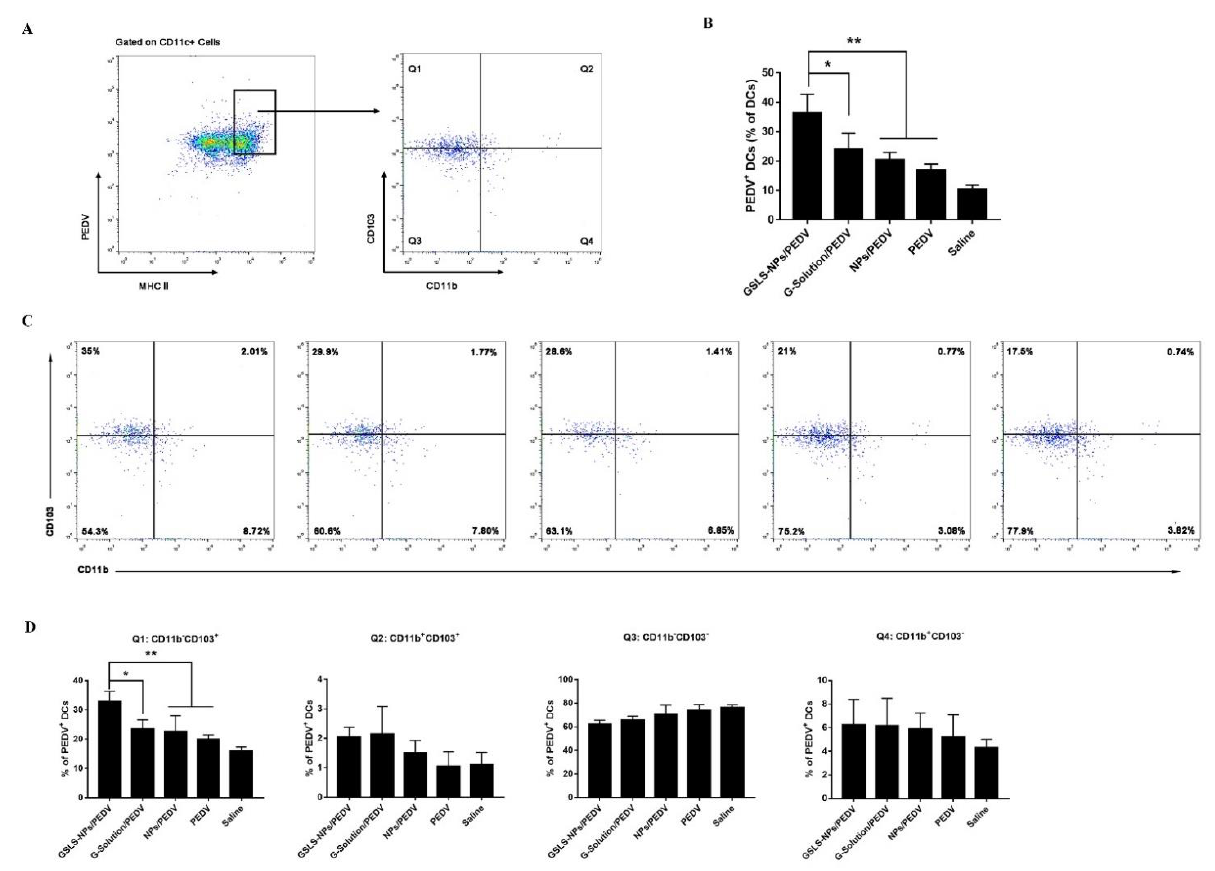
Figure 6. Responses of dendritic cell subsets in the MLNs. Mice (n = 6) were gavaged and immunized as described above, and mononuclear cells were isolated from the MLNs after euthanasia on day 23. ( A , B ) Proportion of PEDV-positive DCs. ( C ) Representative flow cytometry plot of the DC subset distribution. ( D ) Frequencies of PEDV-positive DC subsets. Data are presented as the mean ± SD. * p < 0.05, ** p < 0.01. Unpaired Student’s t test.